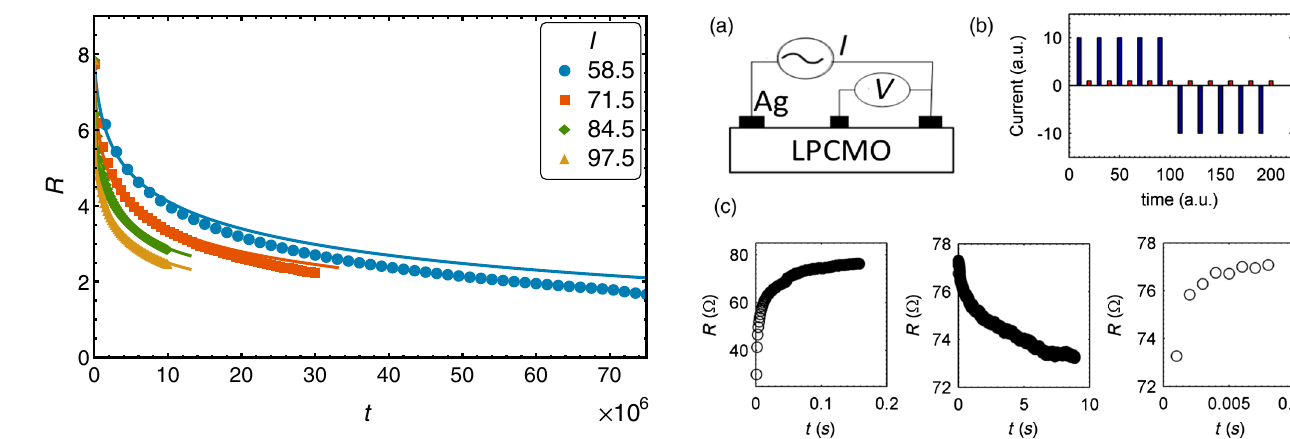
FIG. 8. (a) Diagram of the experimental setup. (b) Sketch of the pulsed current protocol used in the experiments. A high- current Write pulse (blue) is followed by a low-current Read pulse (red). The first pulse generates the RS, while the second pulse measures the nonvolatile resistance. (c) R vs t curves from a complete RS process. The system is first taken to a HI resistance state under a current of -350 mA (left panel). Then, the HI to LO RS is measured under an applied current of 37.5 mA (middle panel). Finally, the system is taken back, i.e., “ reinitial- ized, ” to a HI resistance state with the application of a -350 mA